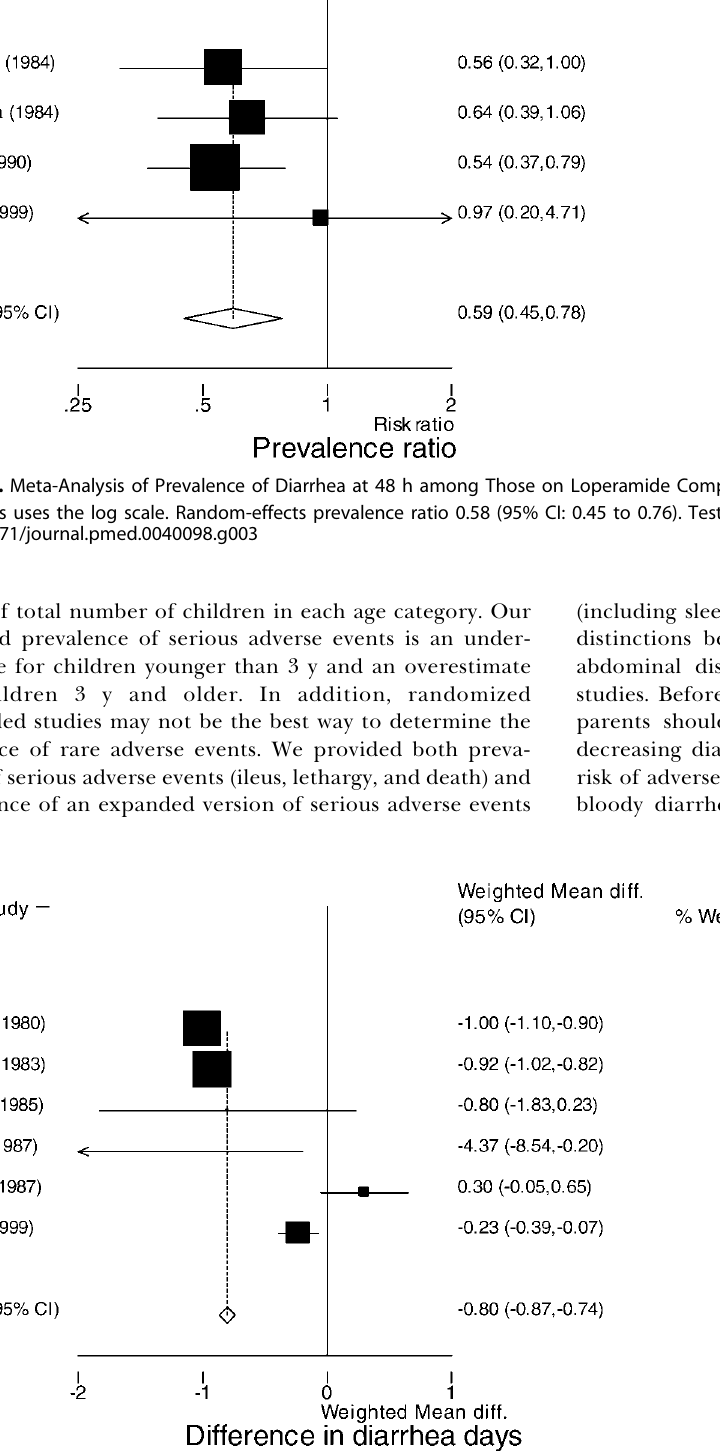
Figure 4. Diarrhea Duration Reduction of diarrhea duration (days) in six included studies that reported mean reduction and variance using the fixed-effects method: 0.8-d reduction in diarrhea (95% CI: 0.74 to 0.87 d). Box size is proportional to the inverse magnitude of the study variance. Random-effects reduction in diarrhea duration: 0.56 d (95% CI: 0.16 to 0.95 d). Test for heterogeneity, p , 0.001. doi:10.1371/journal.pmed.0040098.g004 PLoS Medicine |